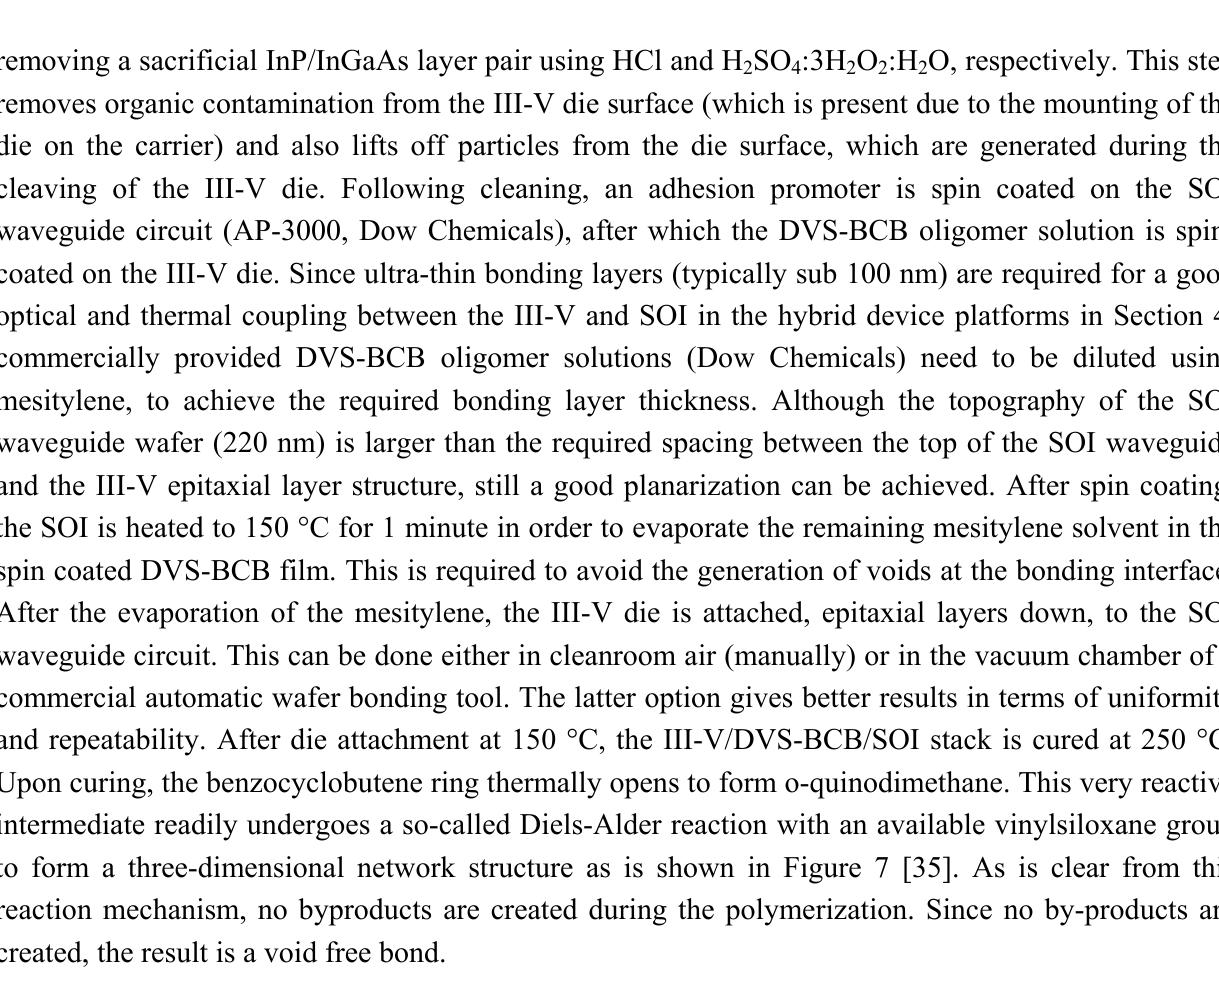
Figure 7. Polymerization reaction of the DVS-BCB